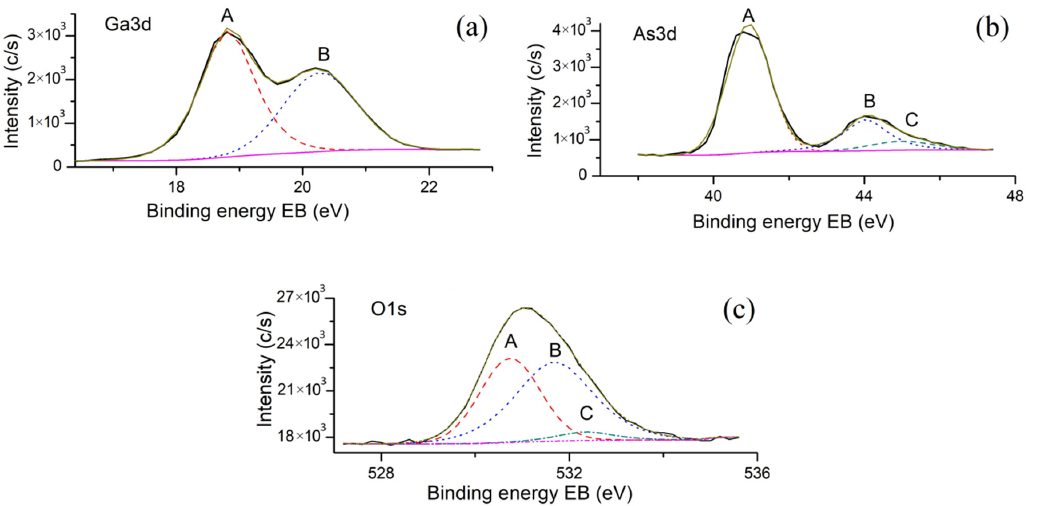
Figure 7. X-ray photoelectron Ga3d ( a ), As3d ( b ), O1s ( c ) spectra obtained for initial area of the GaAs surface.